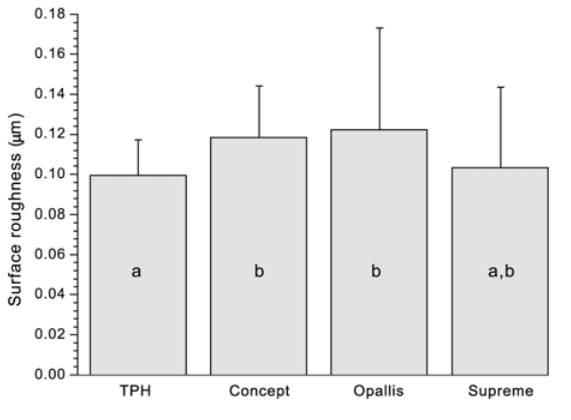
FIGURE 2- Surface roughness before pH-cycling. Columns with the same letters do not differ significantly ( α = 0.05) TABLE 3- Results of paired t-test for surface roughness means (Ra; mm) before and after pH-cycling